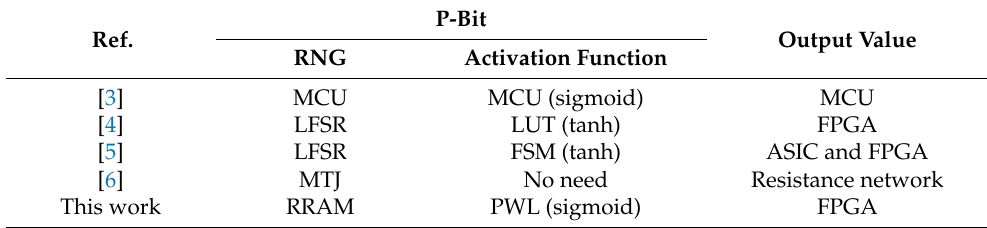
Table 2. Hardware implements of invertible logic.